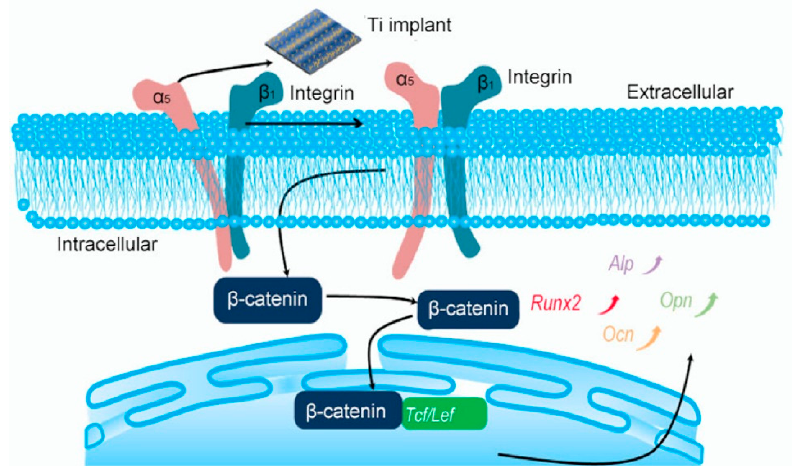
Figure 7. Schematic illustration of patterned Ti for osteogenic differentiation. Function 1: Activation of integrin α 5 β 1 heterodimers and regulation of cell morphology. Function 2: Stimulation of MSCs and MC3T3-E1-related gene and β -catenin expressions to promote osteogenic differentiation. Reproduced with permission from [113], copyright Elsevier, 2020.